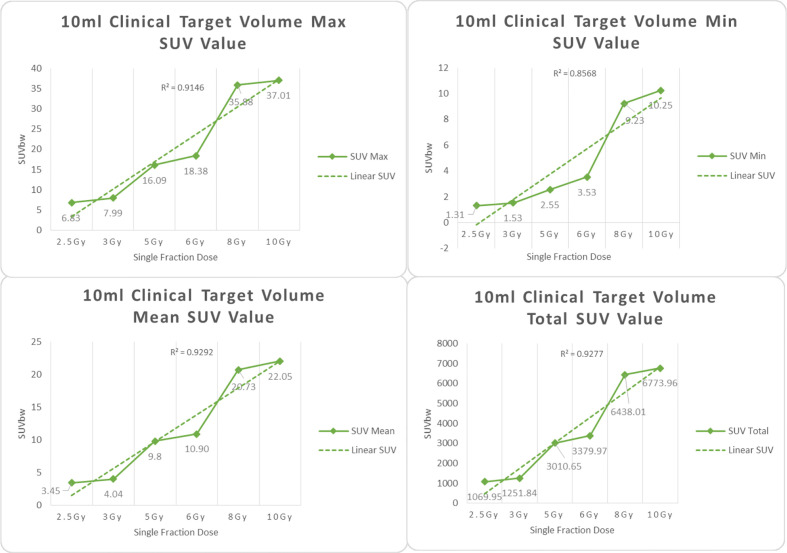
Maximum, minimum, average, and overall SUV of 10 ml clinical volume for different target doses.